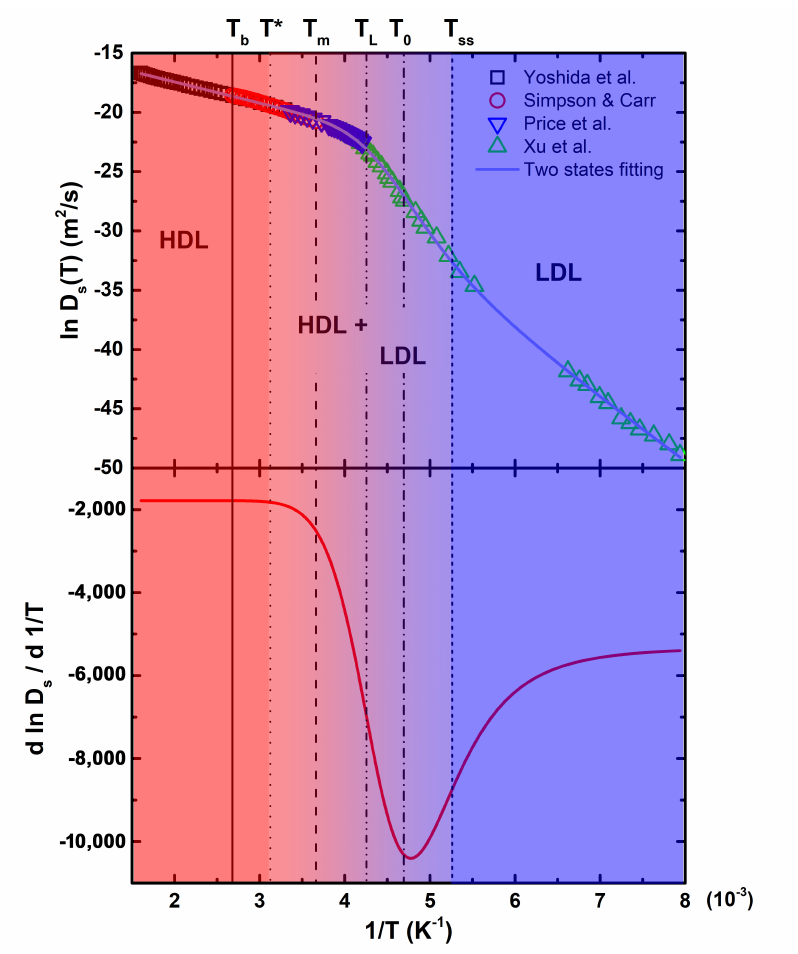
Figure 1. The natural logarithm of the self-diffusion coefficient for liquid water ( top ), fitted with the two-states model and the corresponding first derivative, with respect to the inverse temperature ( bottom ) in a wide thermal region 126 K < T < 623 K. Vertical lines refer to the relevant temperatures discussed in the